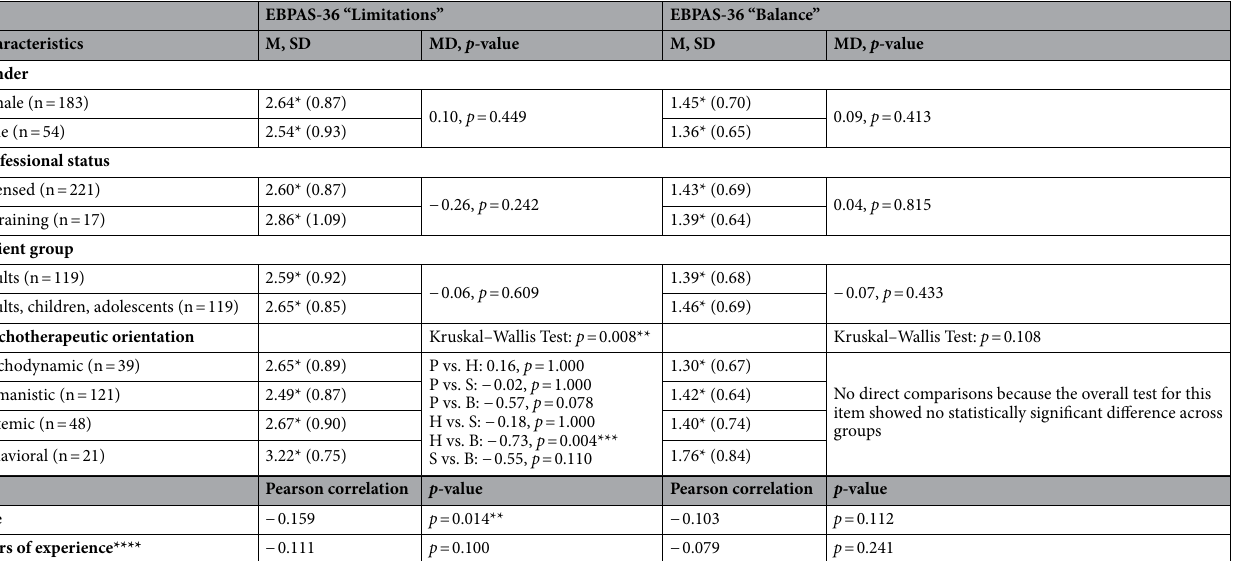
Table 4. EBPAS-36 “Limitations” and “Balance” subscales across subgroups. * Reversed ratings; a higher value indicates a more positive attitude toward EBP. ** = Statistically significant difference. *** =